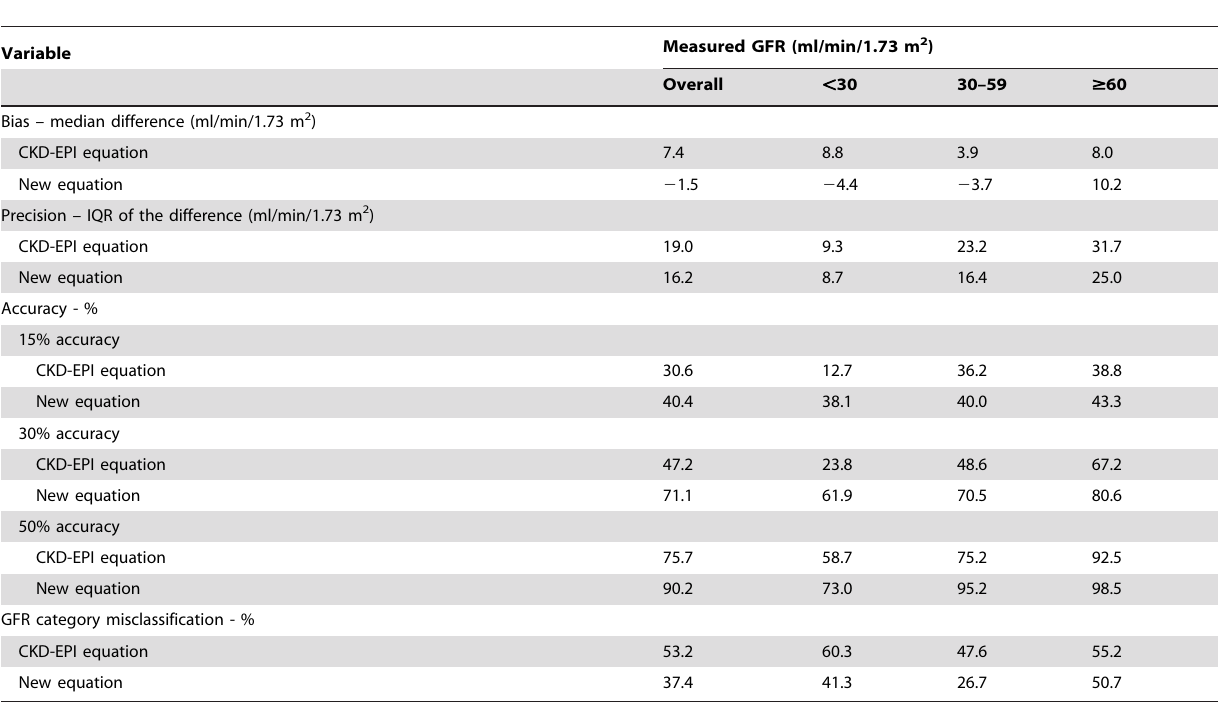
Table 3. Performance of bias, precision and accuracy between measured GFR and estimated GFR in the validation data set.